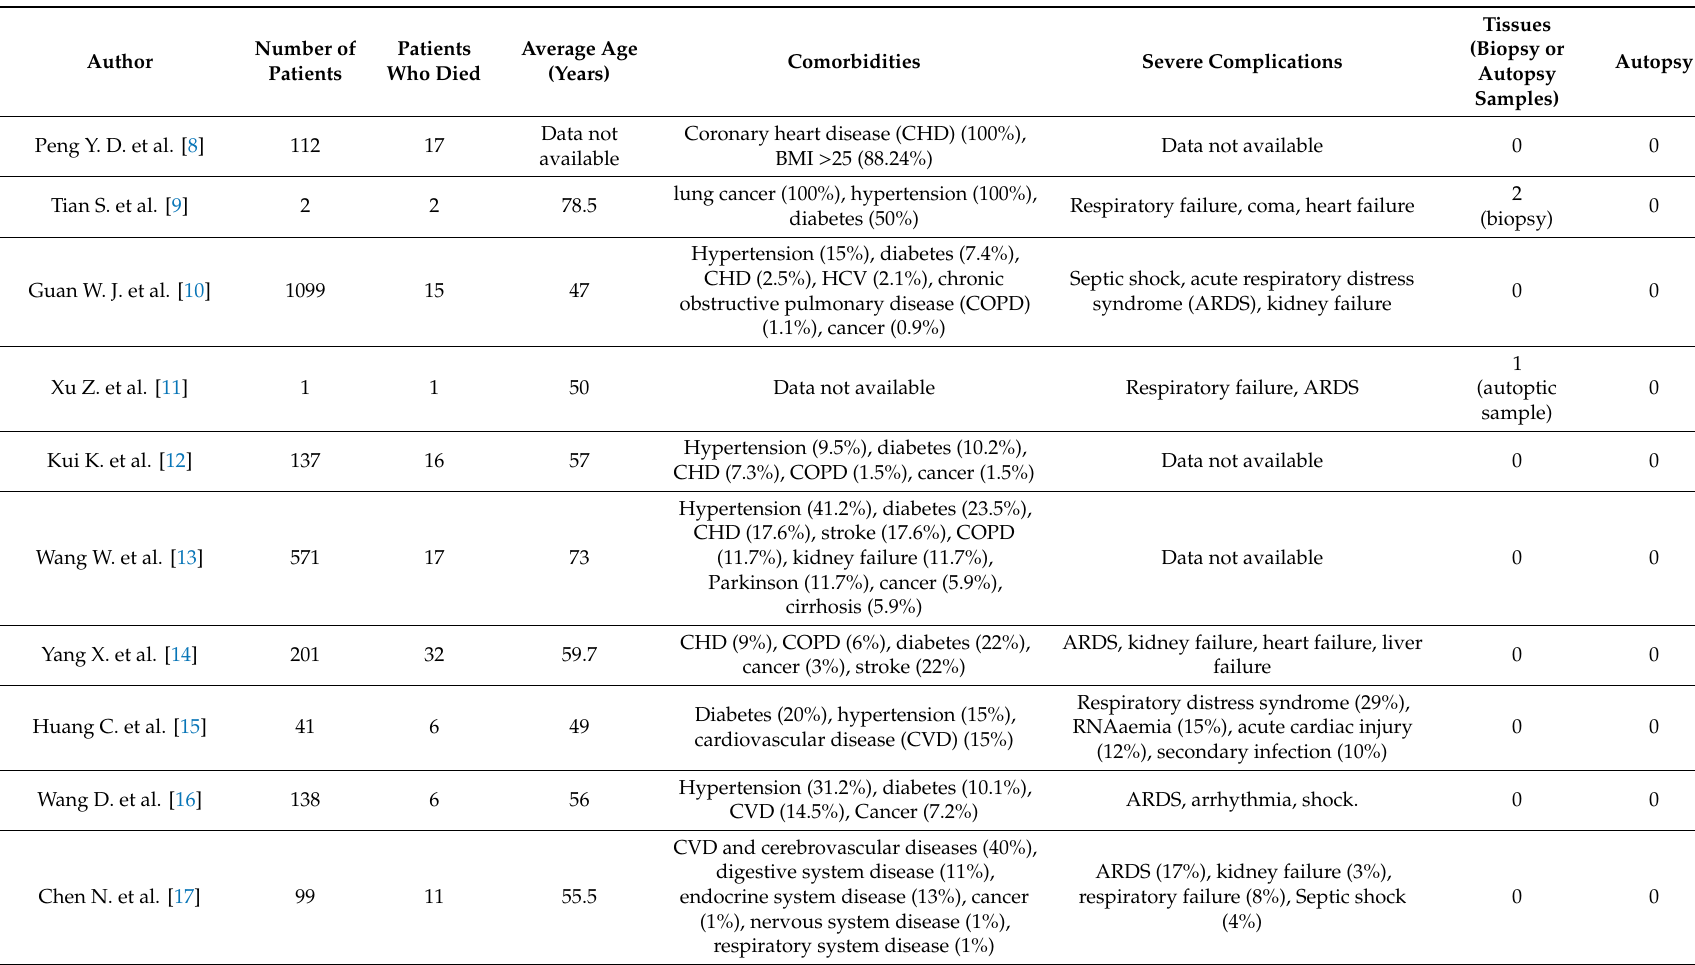
Table 1. The main characteristics of the selected studies are summarized in the table. All studies were published in peer-reviewed journals indexed in PubMed in 2020.